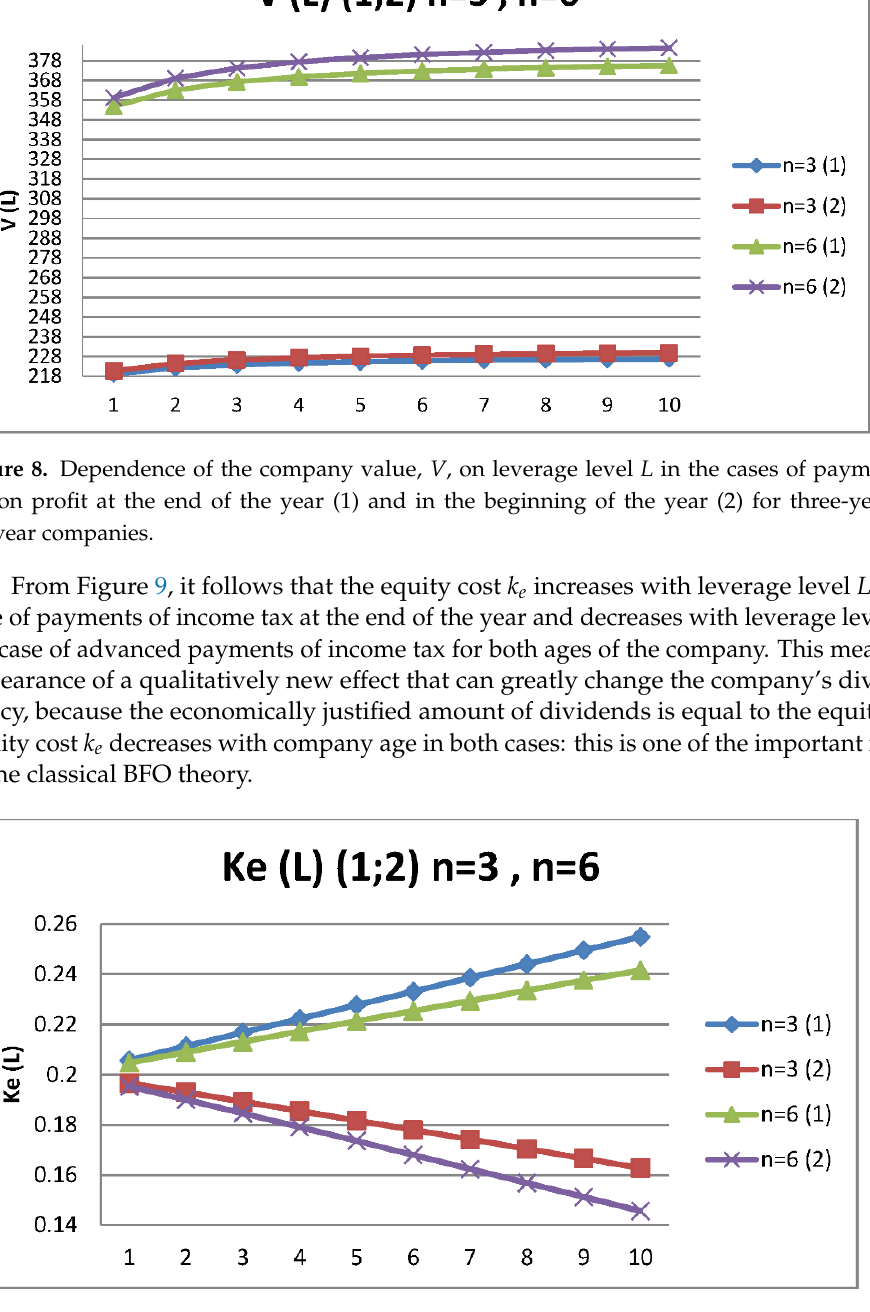
Figure 9. Dependence of the equity cost, k e , on leverage level L in the cases of payments of tax on profit at the end of the year (1) and in the beginning of the year (2) for three-year and six-year companies.